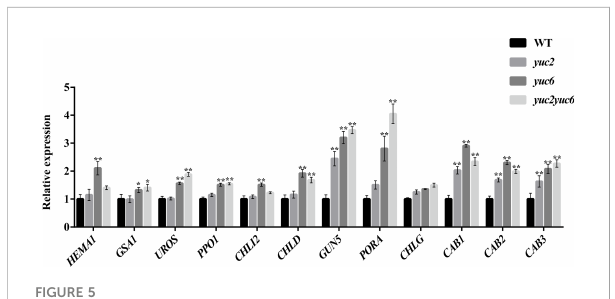
FIGURE 5 Chlorophyll gene expression of rosette leaves. * represents p value <0.05, ** represents p value <0.01.